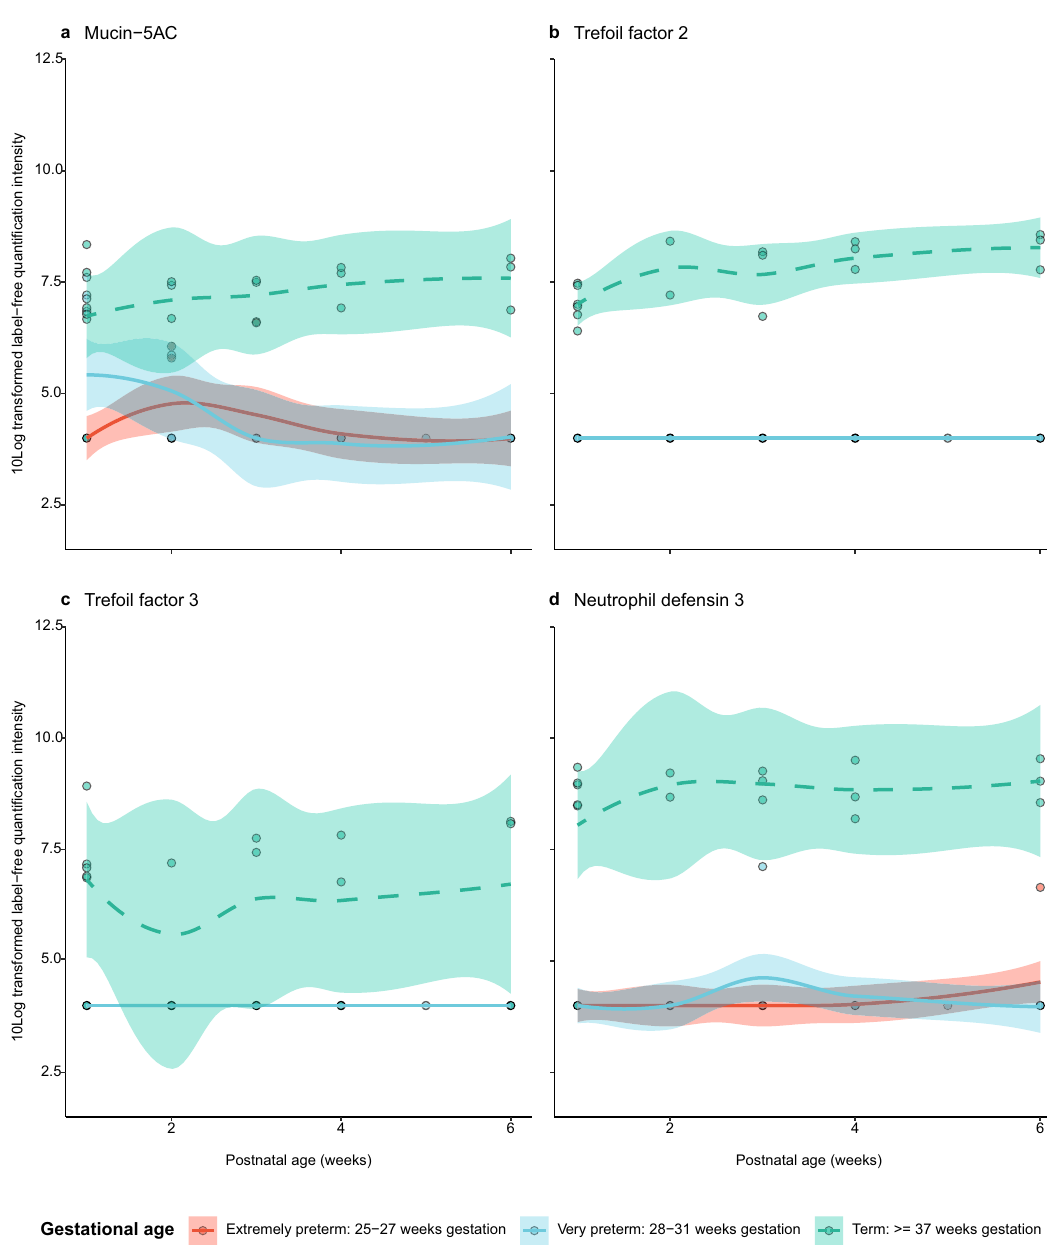
Figure 6. Temporal dynamics of gastrointestinal integrity and maturation markers in the fecal proteome of preterm and term infants. ( a ) Mucin-5AC, ( b ) trefoil factor 2, ( c ) trefoil factor 3 and ( d ) neutrophil defensin 3. The y-axis shows 10Log transformed label free quantification (LFQ) intensity. The x-axis shows the postnatal age in weeks for each gestational age